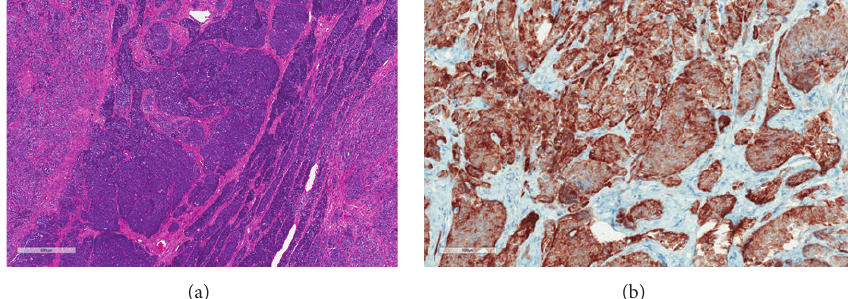
Figure 2: Testicular granulosa cell tumor histology. Sections of the testis show a nested neoplasm composed of undifferentiated to poorly differentiated cells infiltrating through the interstitium. The cells have scant cytoplasm and round-to-oval nuclei with occasional longitudinal nucleargroves.Thereisasuggestionofrosetteformationinsomeareas,whichcouldrepresentCall-Exnerbodies.Mitoticfiguresareidentified. The overall morphology is consistent with a granulosa cell tumor, adult type (a). Immunohistochemistry shows that the tumor cells are diffusely positive for inhibin (b).